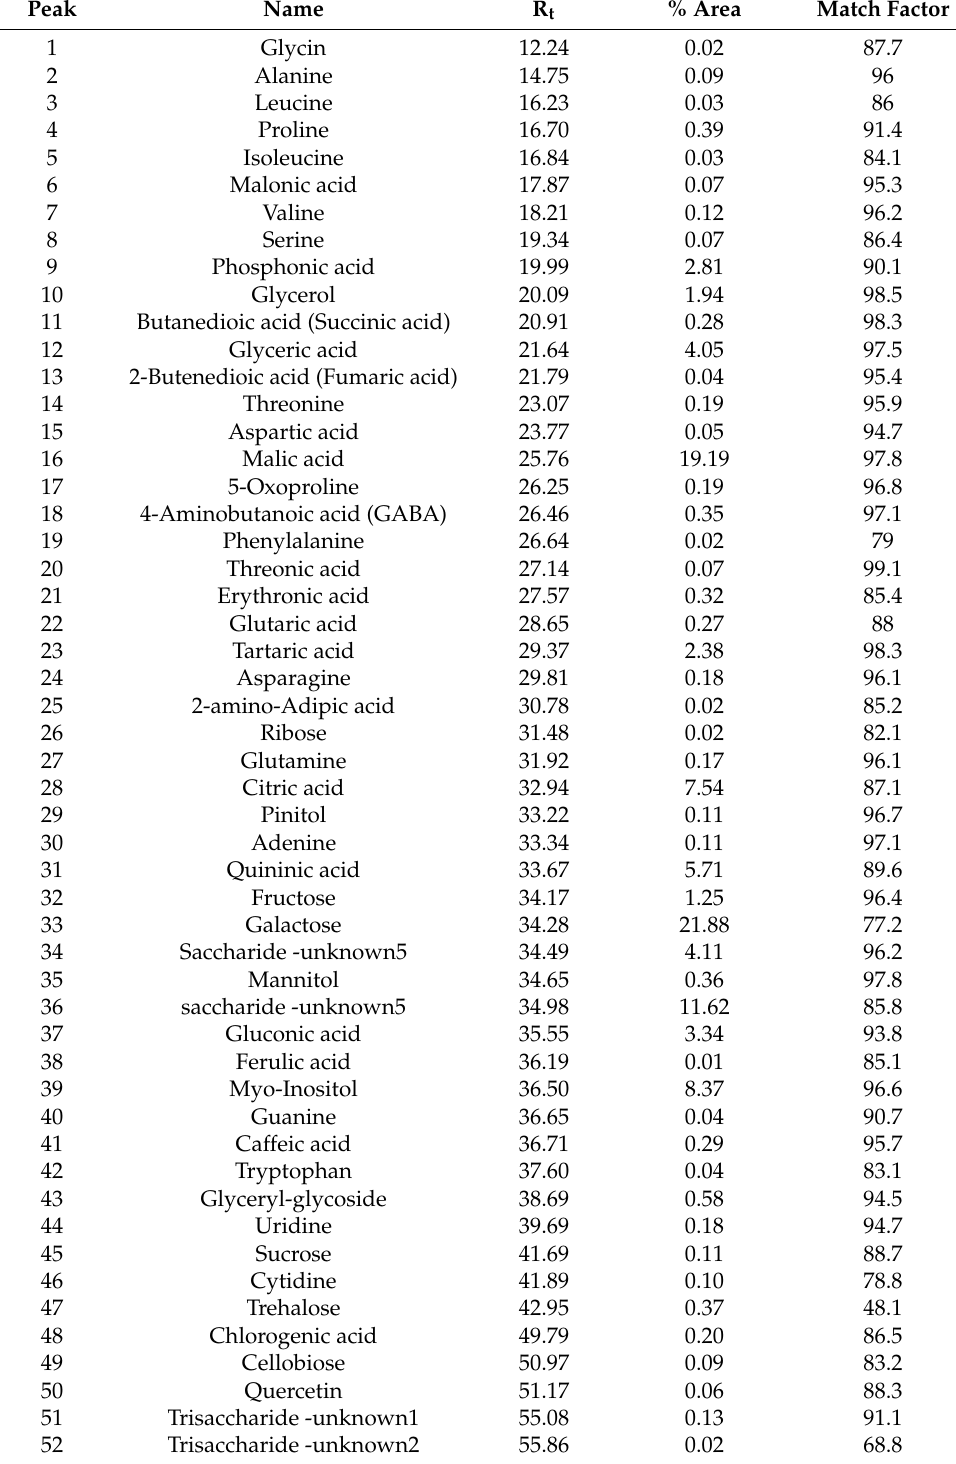
Table 2. Phytochemicals of O. stamineus from water extract verified by GC/MS.